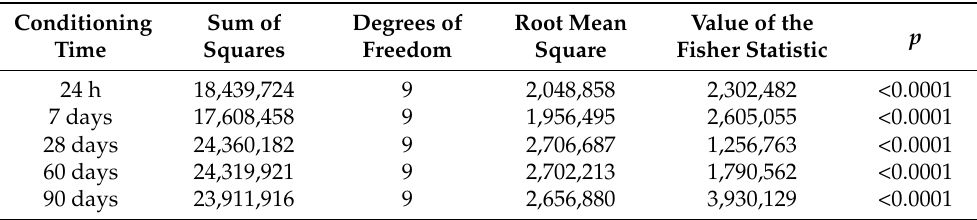
Table 2. Influence of the type of relining material used on the Shore A hardness.